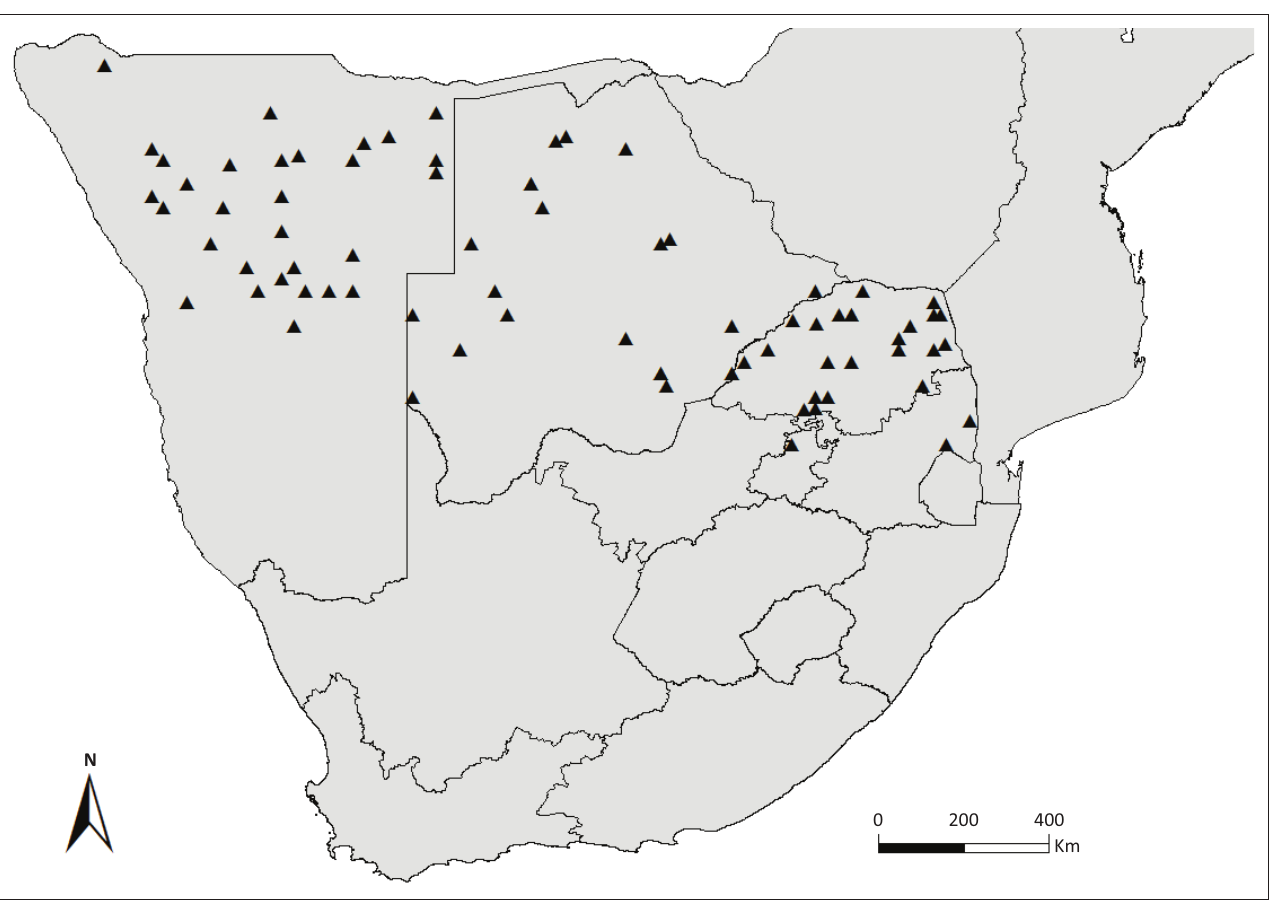
FIGURE 2: Geographical distribution of N. mitis in southern